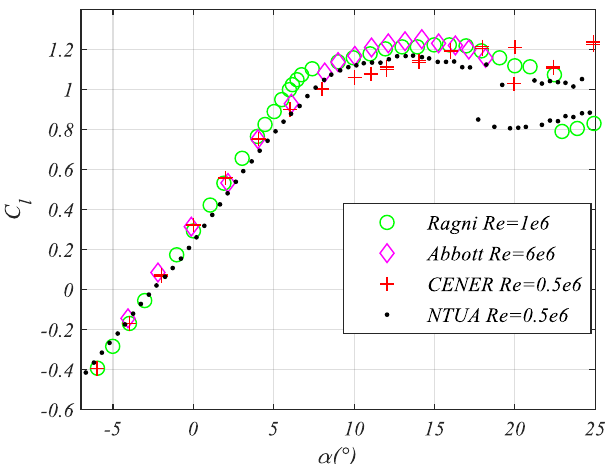
Figure 11. C l versus angle curves. Comparisons with experimental data from literature [22–24].